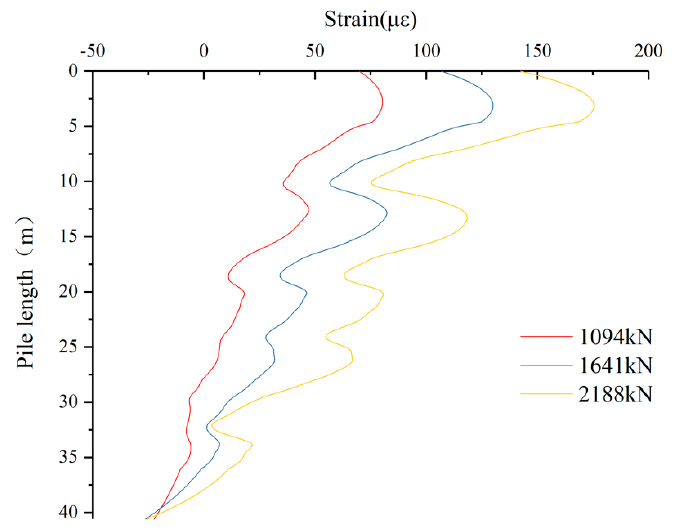
Figure 6. Savitzky-goiay method smoothing signal.